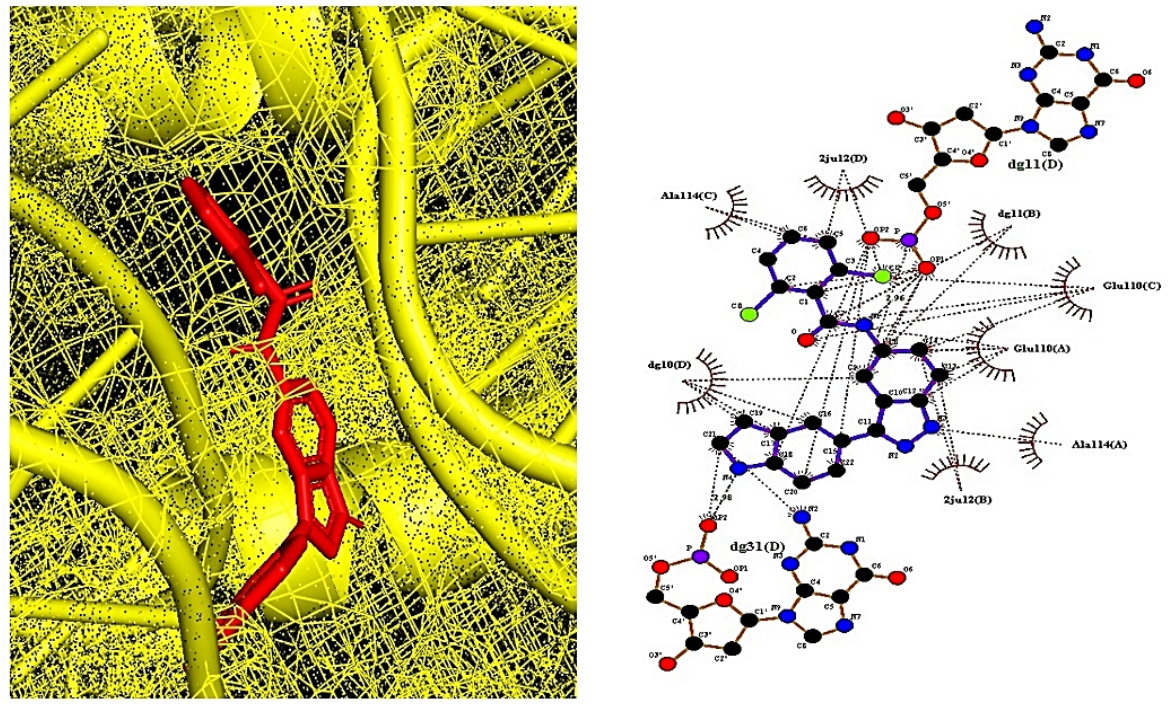
Figure 5. The molecular docking between IL-6 (PDB ID: 4NI9) and MD2-TLR4-IN-1 (PubChem ID: 138454798). Table 4. A prediction of toxicological propensity of MD2-TLR4-IN-1 ( PubChem ID: 138454798). Parameters